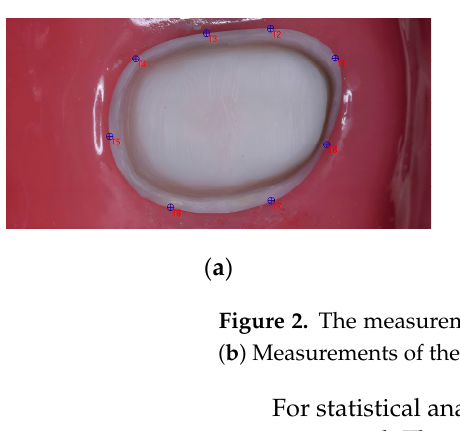
Figure 1. The upper second molar on the cast ( a ) The prosthetic equator, marked with a black pencil; ( b ) The calibration of the digital measurements.